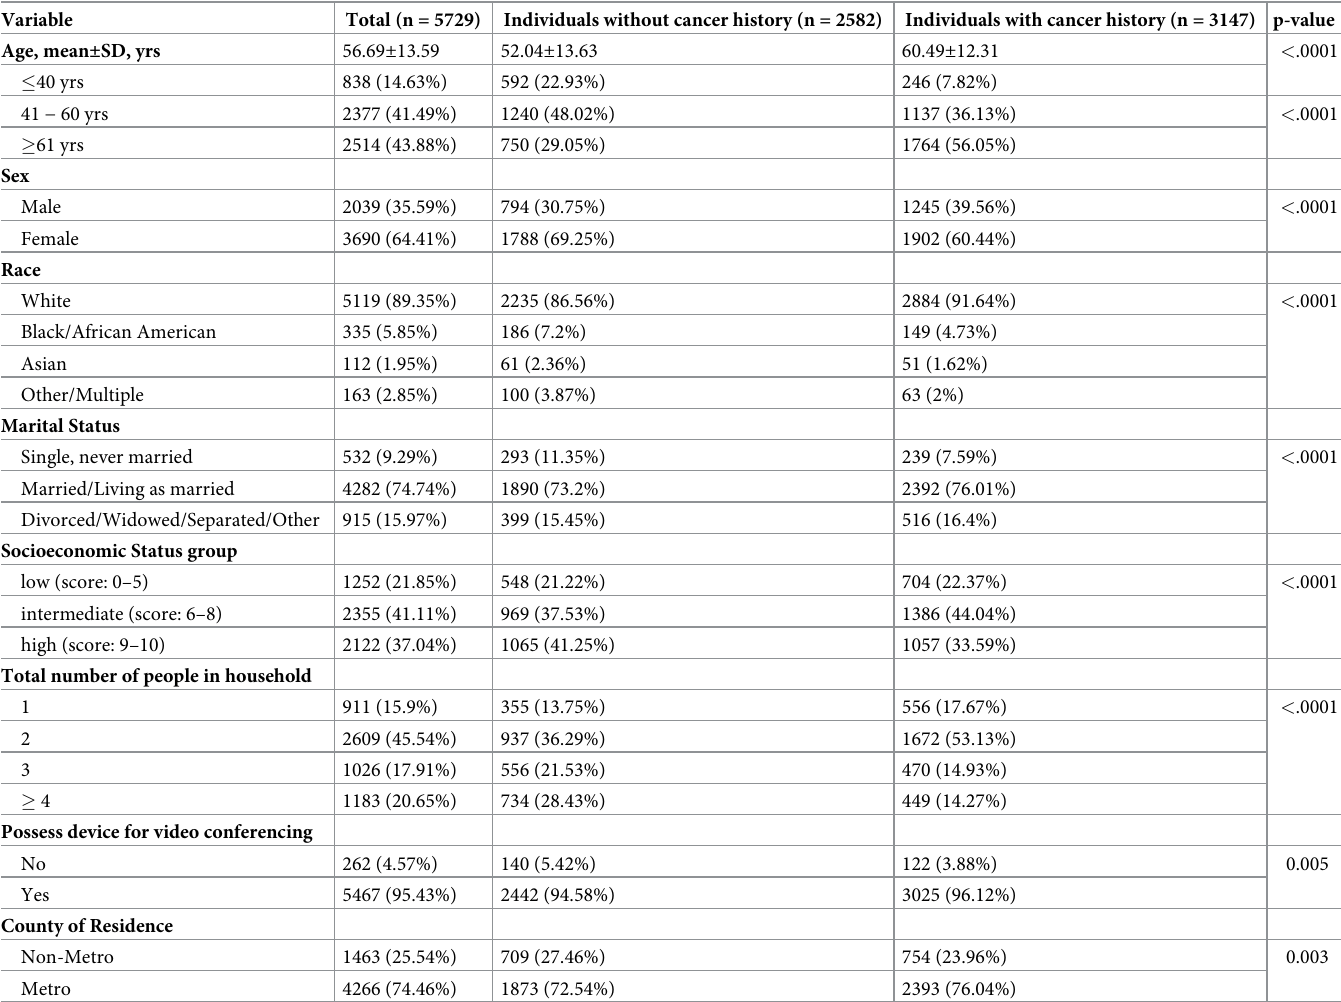
Table 1. Demographic characteristics of participants stratified by cancer